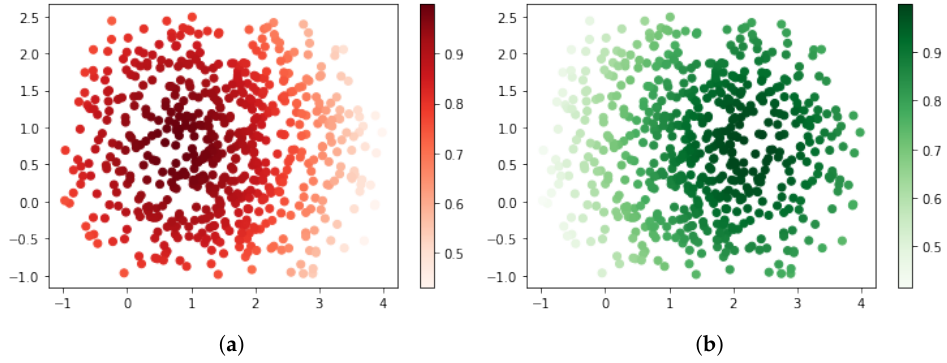
Figure 7. ( a ) Affinity plot of class 1 of dataset depicted in Figure 6a. ( b ) Affinity plot of class 2 of dataset depicted in Figure